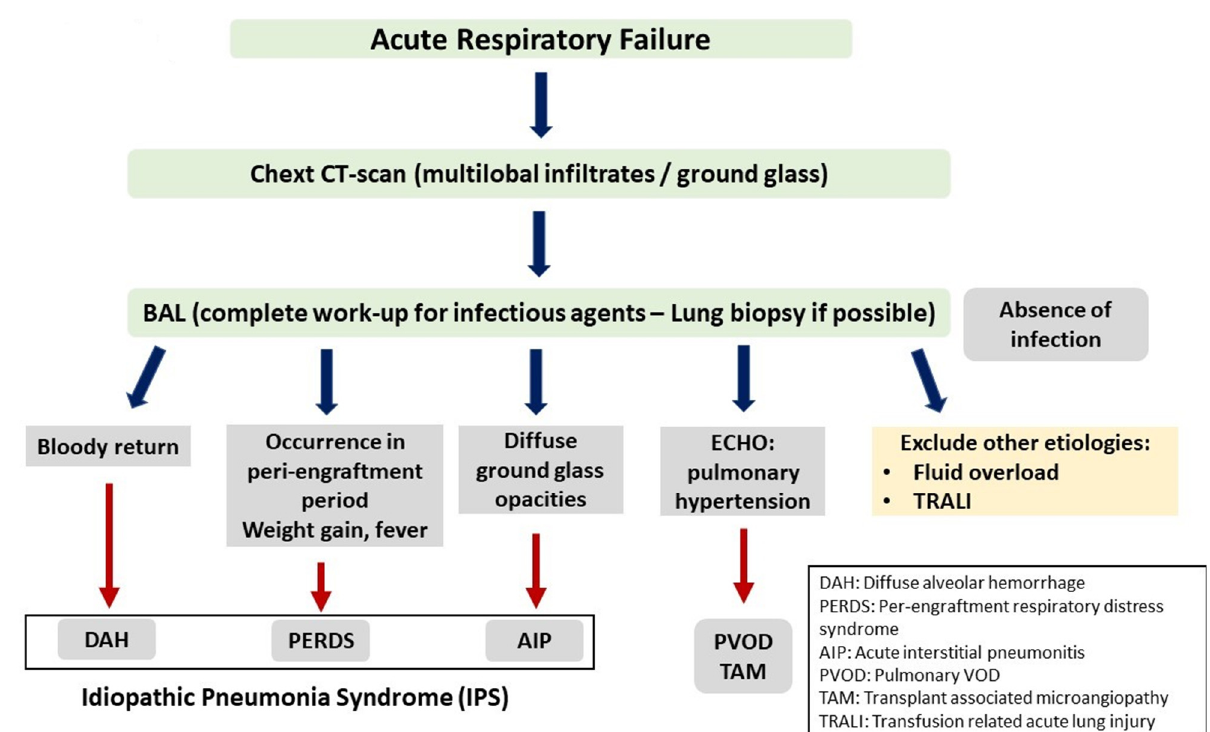
Figure 1. Idipathic Pneumonia Syndrome.